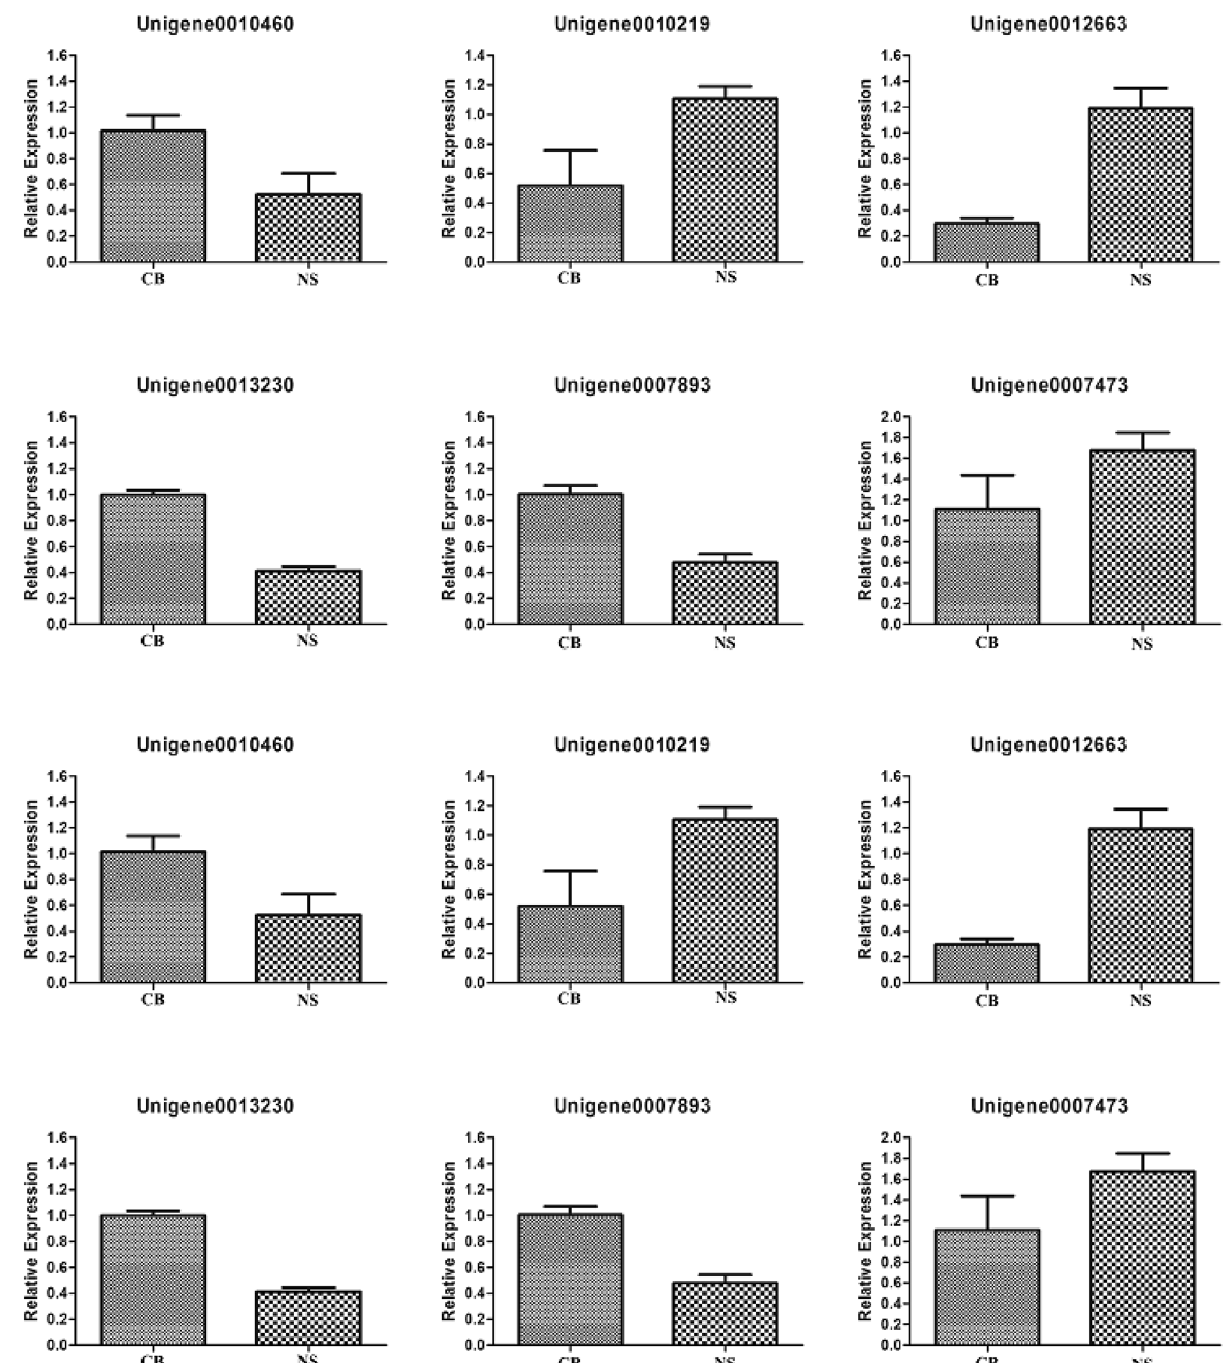
Figure 5. qRT-PCR verification diagram between C. cicadae myceliawith and without urea. Comparison of theexpression levels determined by qRT-PCR from three biological replicates. All data indicate mean ± standard error(SE). Unigene0010460, Glucose-6-phosphate isomerase;Unigene0010219, D-3-phosphoglycerate dehydrogenase; Unigene0012663, L-Serine/L-threonine ammonialyase; Unigene0013230, Aconitase; Unigene0007893, Isocitrate dehydrogenase; Unigene0007473, Acetyl-CoA C-acetyltransferase; Unigene0015804, Hydroxymethylglutaryl-CoA synthase; Unigene0013062, Squalene monooxygenase gene; Unigene0017047, Sterol 14α-demethylase; Unigene0010744, Methylsterol monooxygenase; Unigene0012727,δ-7-Sterol 5-desaturase; Unigene0005363, Sterol